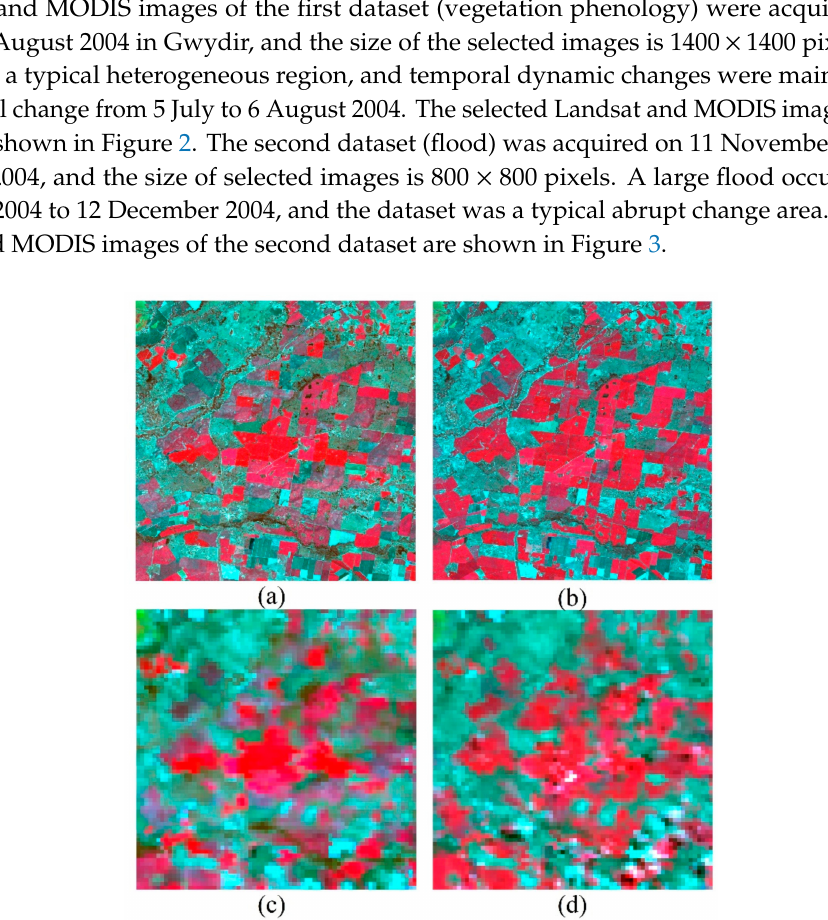
Figure 2. Test data with gradual change (vegetation phenology) in Gwydir. ( a ) Landsat image of 5 July 2004; ( b ) Landsat image of 6 August 2004; ( c ) and ( d ) MODIS images of the same periods as Landsat images. All images use NIR-red-green as